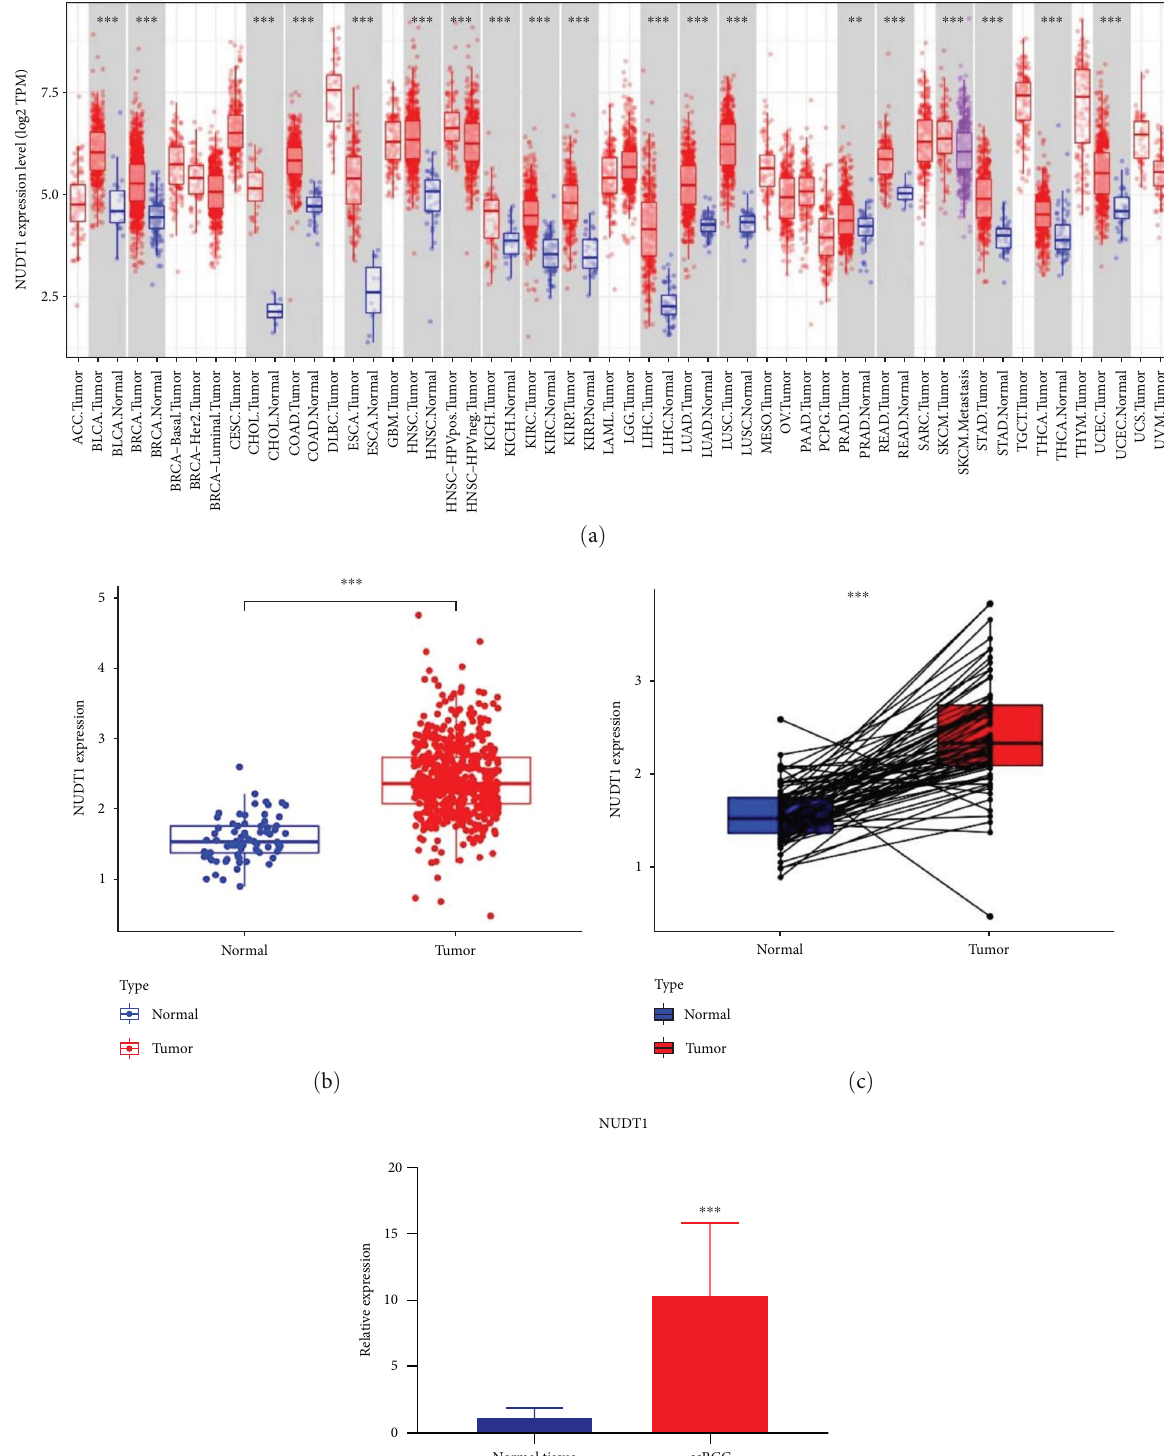
F IGURE 1: Differential expression analysis of NUDT1 in different samples: (a) NUDT1 expression in Pan-cancer data from TIMER database; (b) expression of NUDT1 in ccRCC and normal samples; (c) expression of NUDT1 in ccRCC and its paired adjacent normal tissues; (d) the qRT-PCR validation results of 10 ccRCC tissue and adjacent normal tissue samples. ∗ P < 0 : 05, ∗∗ P < 0 : 01, ∗∗∗ P < 0 :